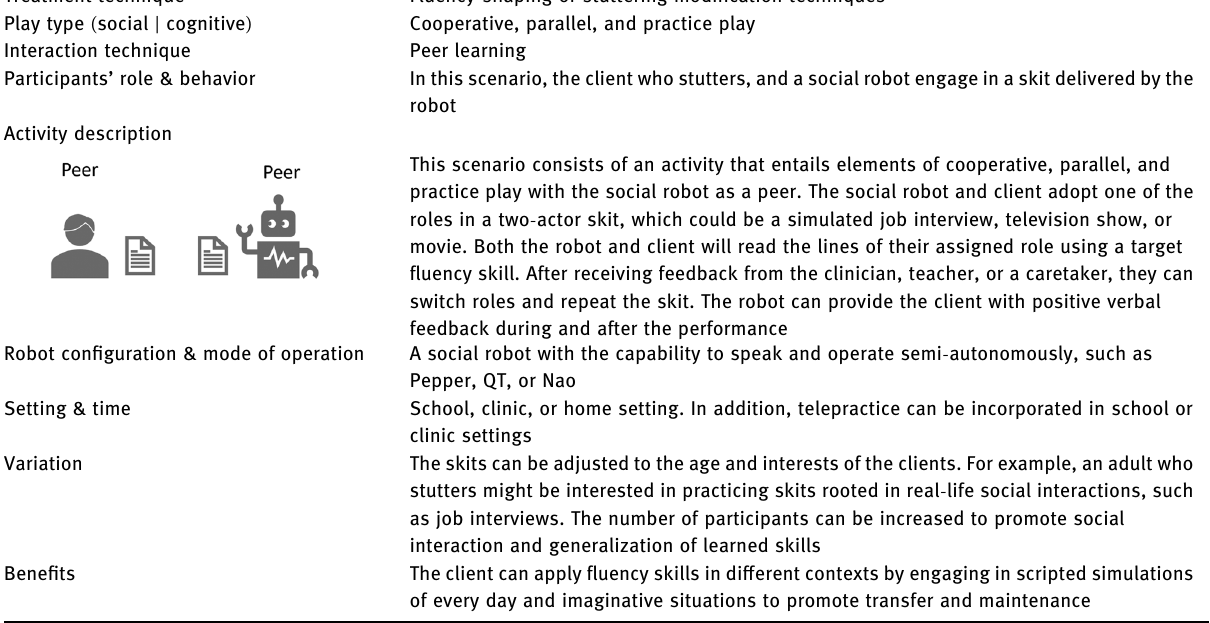
Table 6: Description of scenario 6 Scenario 6: Smooth skits